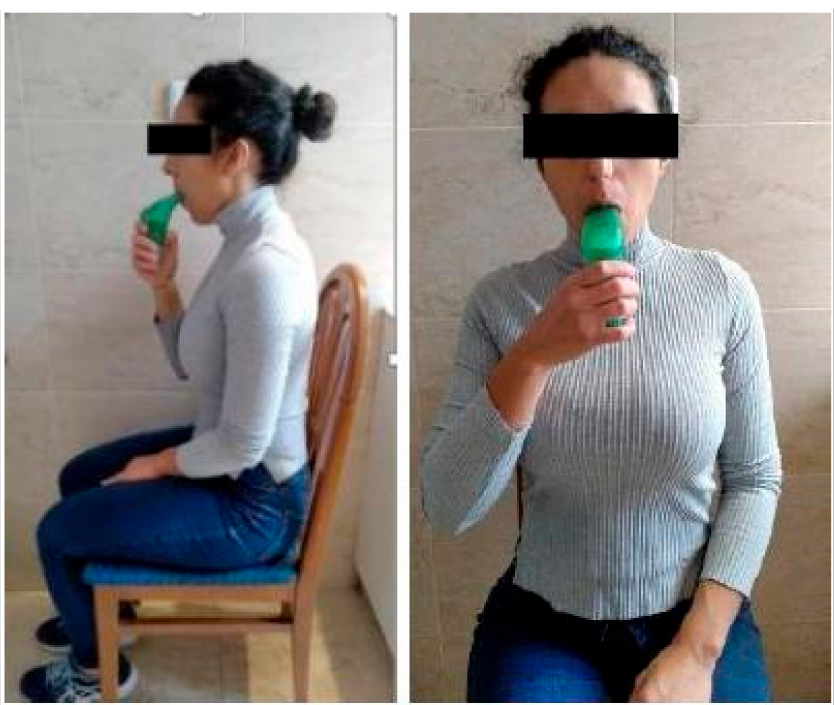
Figure 1. Domiciliary inspiratory muscle training with the POWERbreathe ®